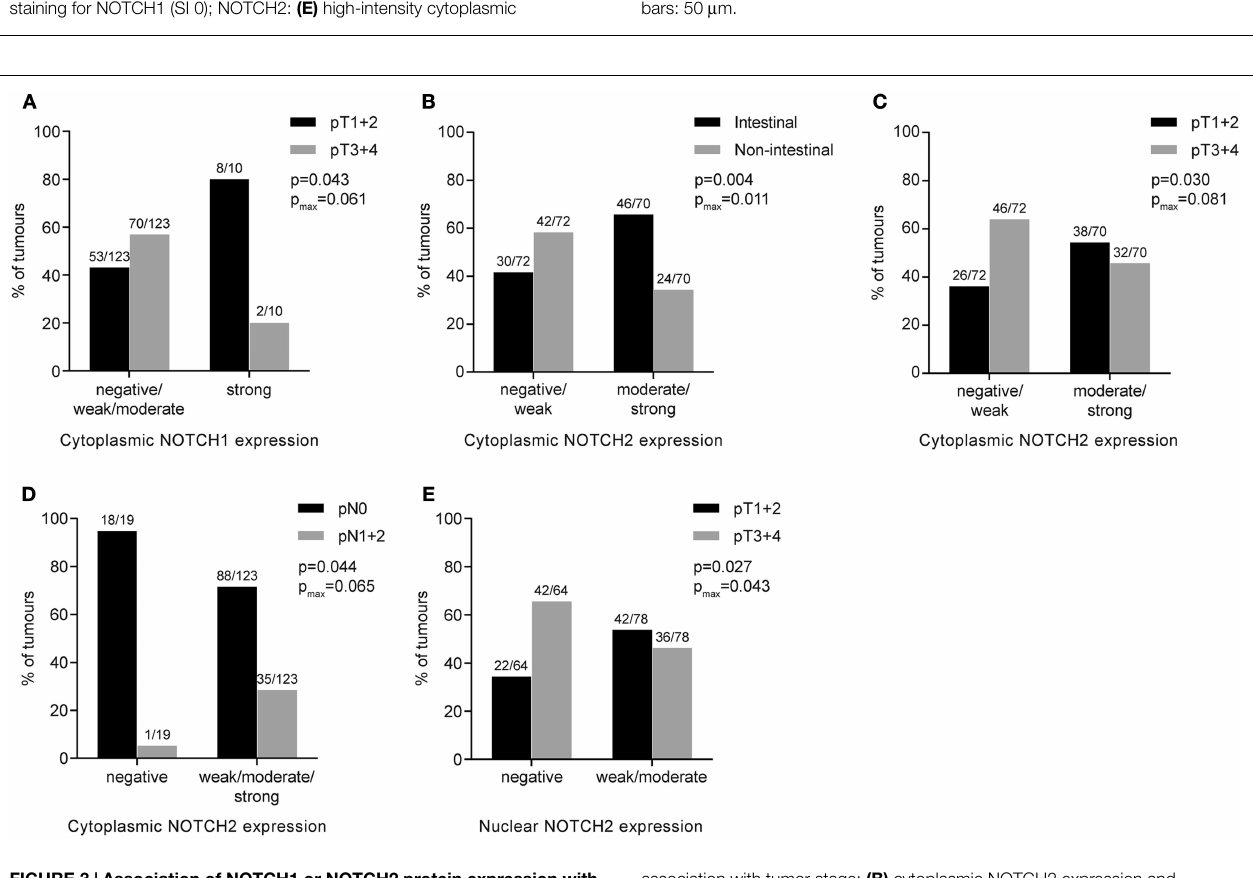
association with tumor stage; (B) cytoplasmic NOTCH2 expression and association with histopathological tumor type; (C) cytoplasmic NOTCH2 expression and association with tumor stage; (D) cytoplasmic NOTCH2 expression and association with lymph node status; (E) nuclear NOTCH2 expression and association with tumor stage.